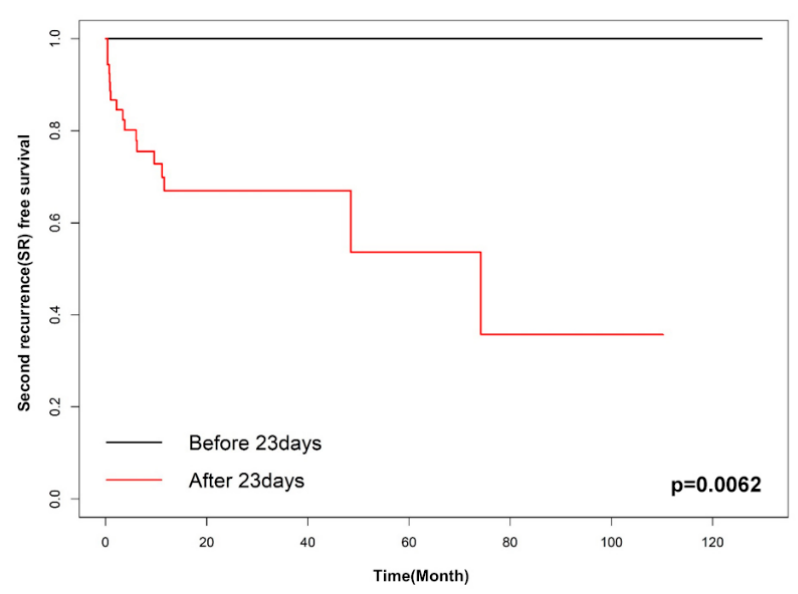
Figure 3. Kaplan–Meier curve of early recurrence and late recurrence (cut-off: 23 days).